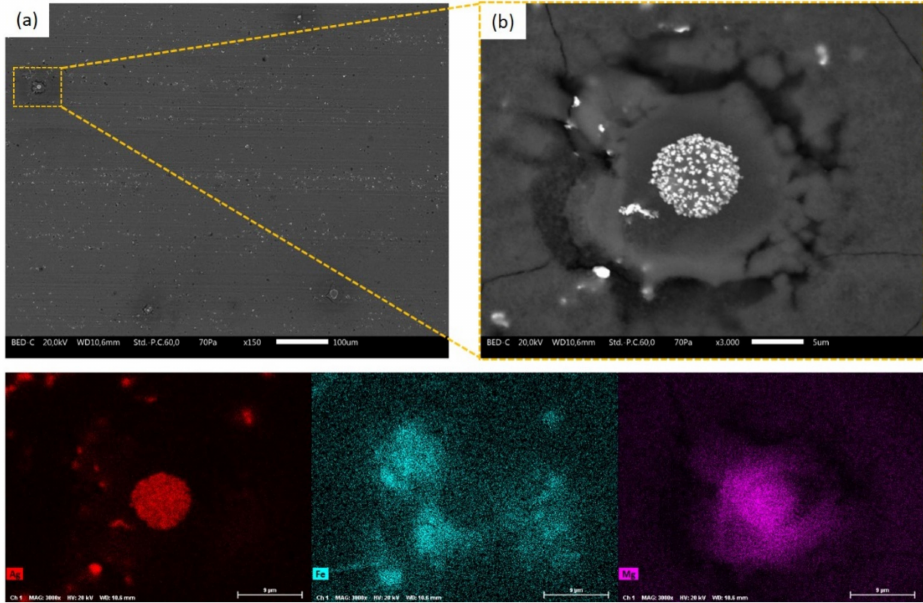
Figure 5. SEM micrographs of sample A after 72 h of exposure ( a ). Magnification of a defect ( b ), with relative EDXS map of Ag, Fe and Mg